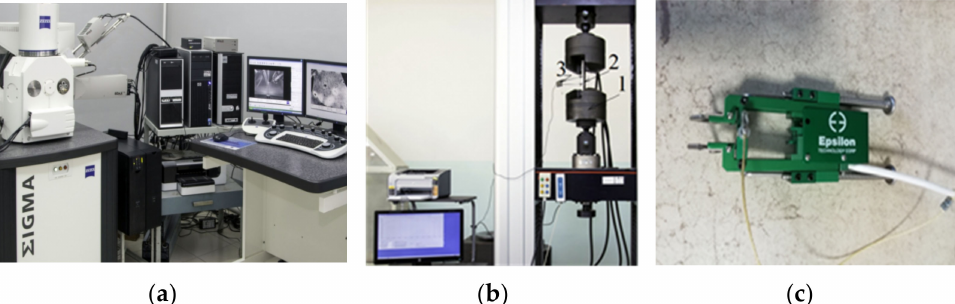
Figure 3. Equipment used in the experimental research: ( a ) Zeiss Sigma scanning electron microscope, ( b ) Instron 8802 dynamic testing machine, and ( c ) Epsilon longitudinal strain sensor (extensometer).